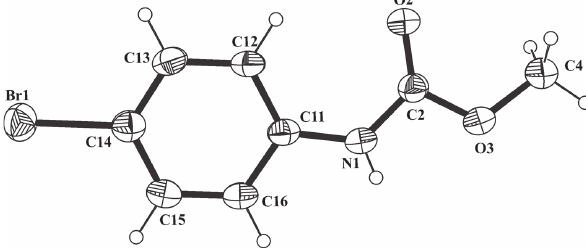
Table 1: Data collection and handling.